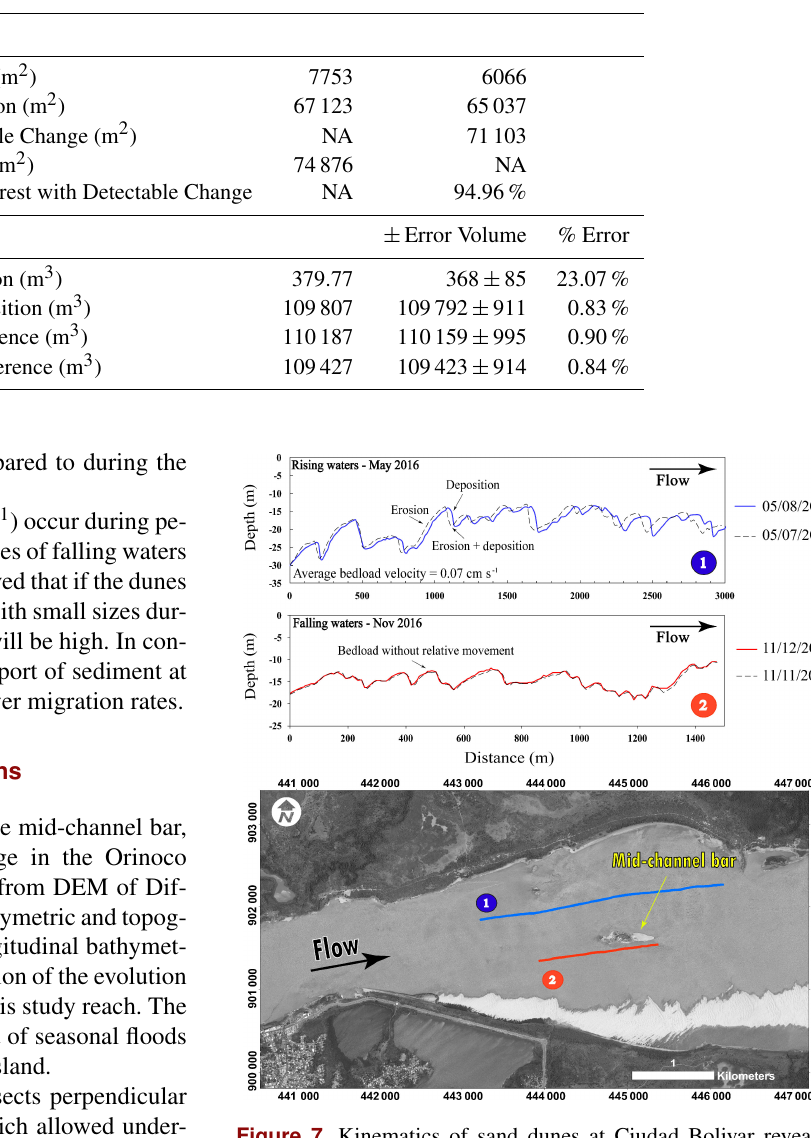
Figure 7. Kinematics of sand dunes at Ciudad Bolivar revealed through bathymetric profiles (upper figures) and a plan view of the profile transects (lower figure). (1) corresponds to rising waters, while (2) corresponds to falling